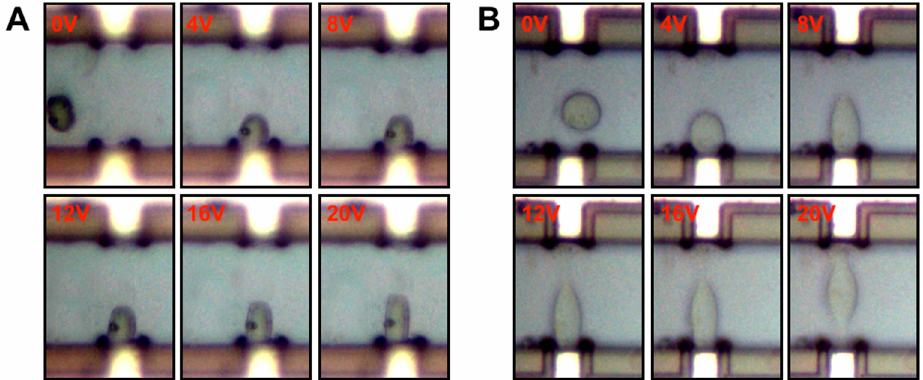
Figure 4. Deformation of ( A ) the unfused stem cell and ( B ) the fused stem cell as a function of the electric field strength.